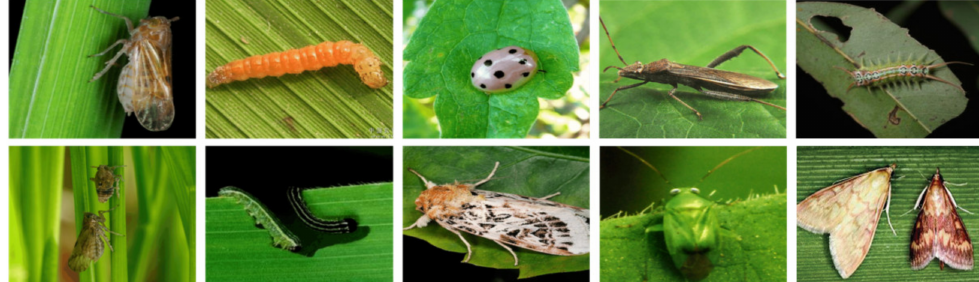
Figure 2. Sample of the pest dataset collected from the public datasets and online resources. The first and second rows display different kinds of pests and their resolutions, such as brown planthopper, rice leaf roller, ladybug, rice ear bug, caterpillar, moth, mirid bug, and corn